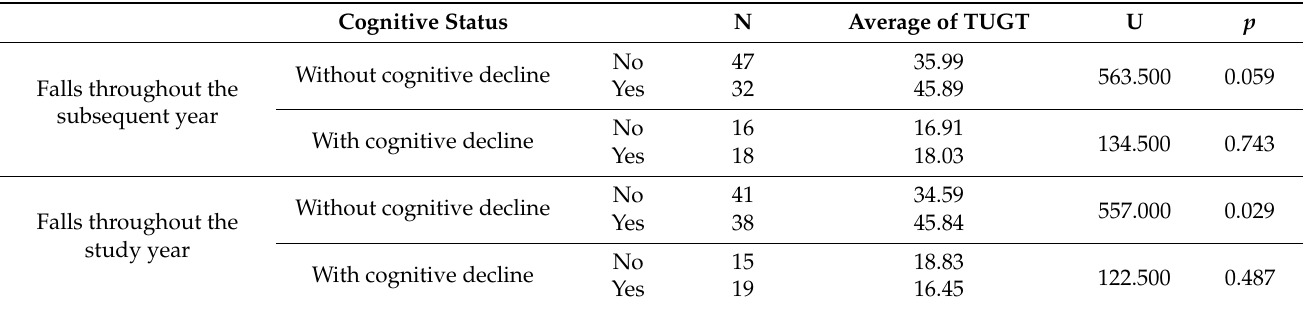
Table 5. Results of the application of the Mann–Whitney U test to gait speed regarding both the existence of a fall episode throughout the study year and the subsequent year, and the cognitive status of the older persons.